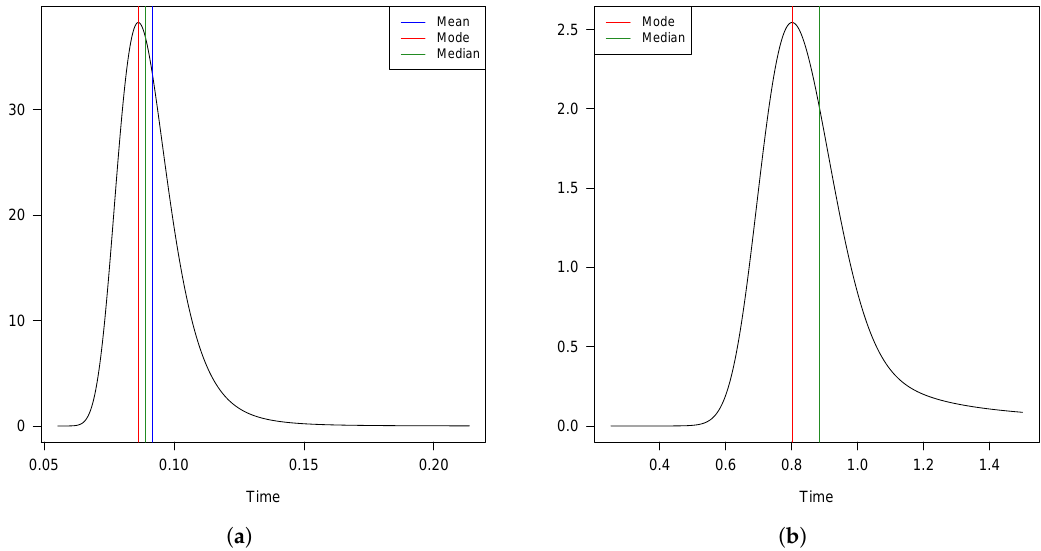
Figure 6. Study of infected: Probability density functions of T S the estimated multi-sigmoidal diffusion process through the constant boundaries S 1 and S 3 shown in Table